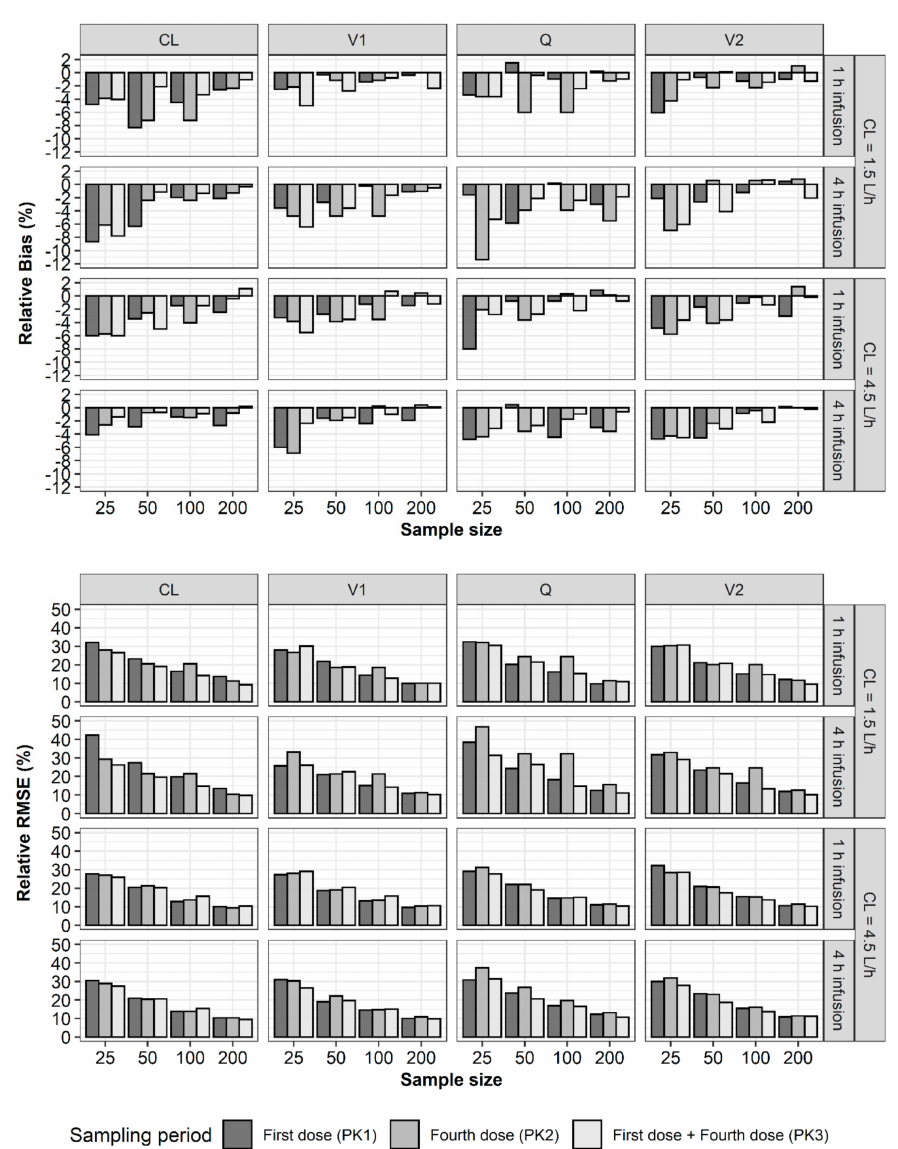
Figure 3. Relative bias ( upper ) and relative RMSE ( lower ) of between-subject variability of structural pharmacokinetic parameters for two-compartment model of vancomycin (CL—total clearance; V1—volume of the distribution of the central compartment; V2—volume of distribution for the peripheral compartment; Q—intercompartmental clearance between V1 and